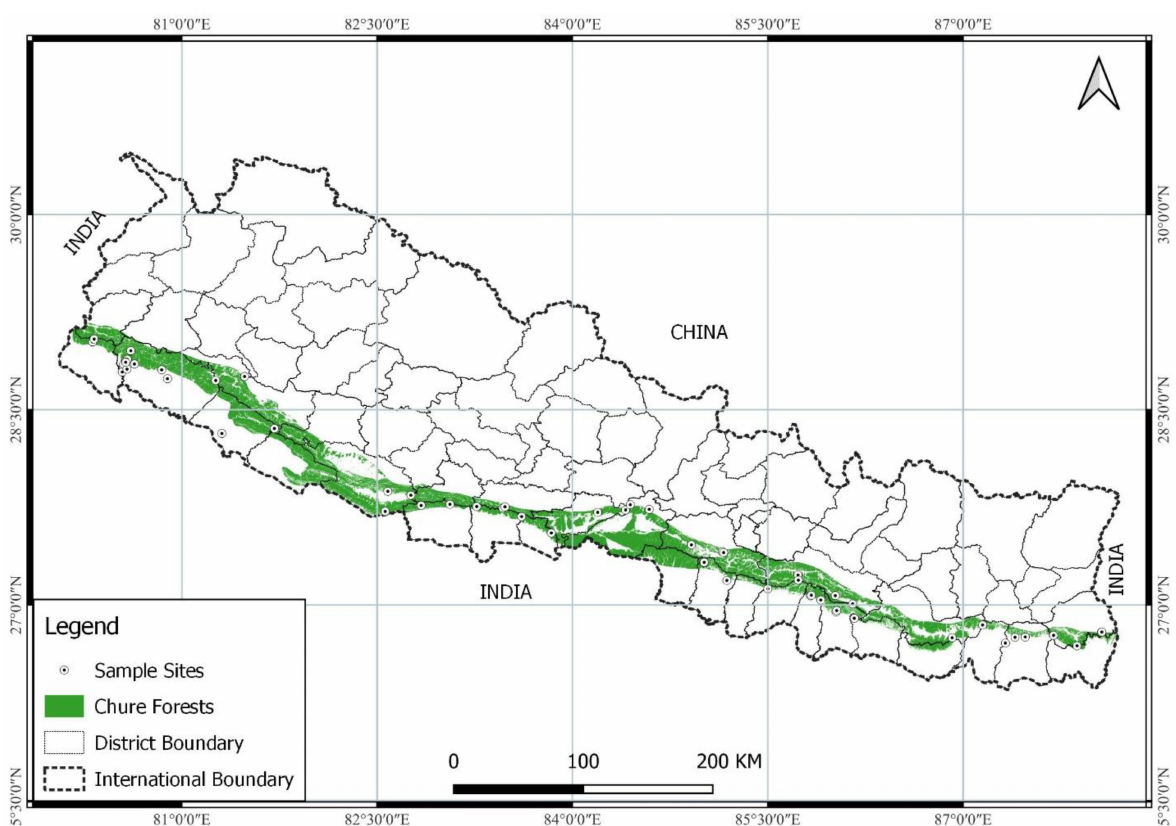
Figure 1. Map of Nepal showing Chure range and forests in green. The black dots represent the sampling